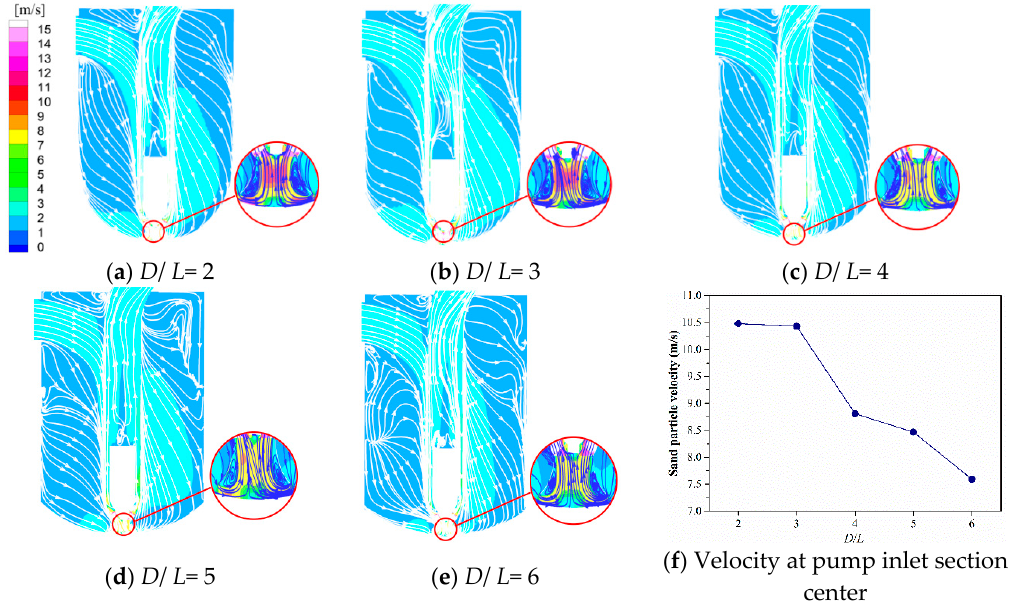
Figure 12. Velocity distributions and streamlines of sand particles in the tank. ( a ) D/L = 2; ( b ) D/L = 3; ( c ) D/L = 4; ( d ) D/L = 5; ( e ) D/L = 6; ( f ) Velocity at pump inlet section center.